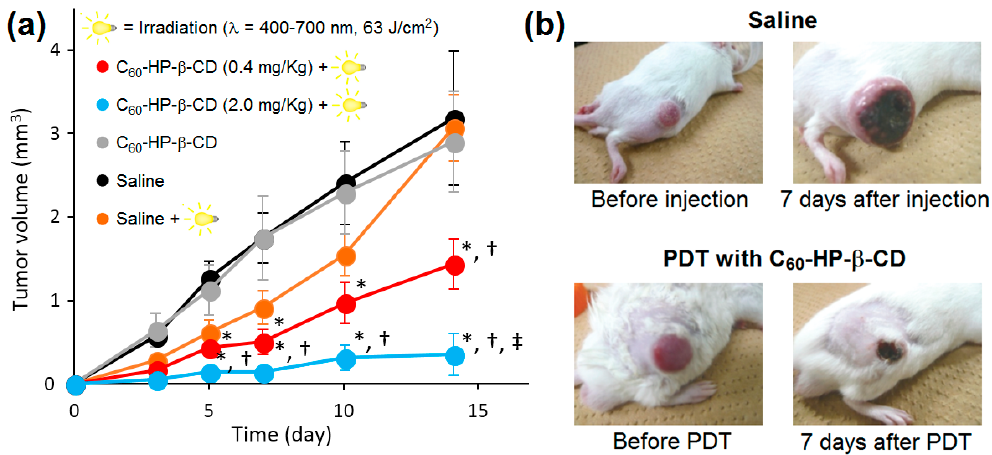
Figure 71. PDT effect of C 60 -HP- β -CD NPs ( a ) on tumor growth and ( b ) changes in body weight of ddY mice in the dark or after irradiation from a xenon light source ( λ = 400–700 nm, 63 J/cm 2 , 350 mW/cm 2 ). Each point represents the mean ± S.E. of six to nine experiments. * p < 0.05 vs. saline. † p < 0.05 vs. saline plus light irradiation. ‡ p < 0.05 vs. C 60 -HP- β -CD (0.4 mg/Kg) plus light irradiation (63 J/cm 2 ). Adapted and reproduced from Altaf; Aldawsari; Banjar; Iohara; Anraku; Uekama; Hirayama [220].